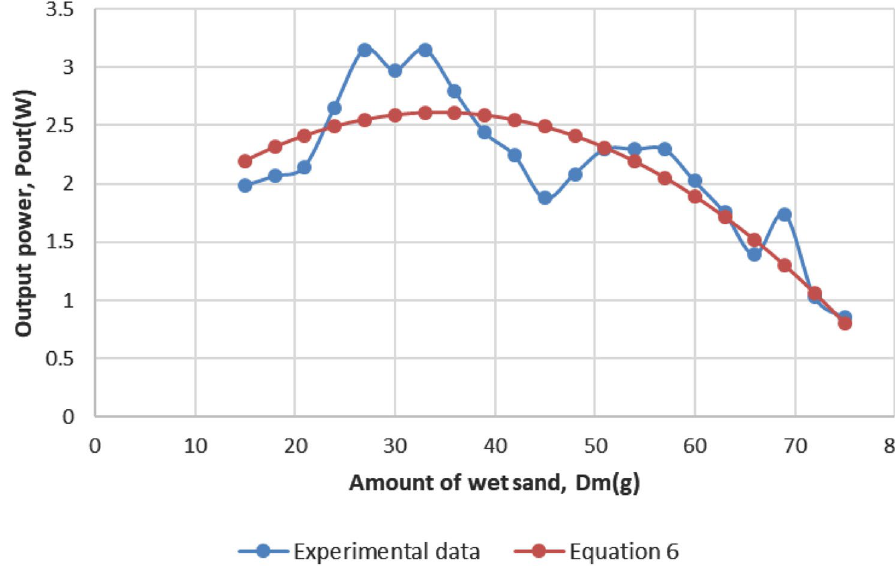
Fig. 11 Comparison of P out ratio calculated from experi- mental data and from quad- ratic regression Eq. (6)